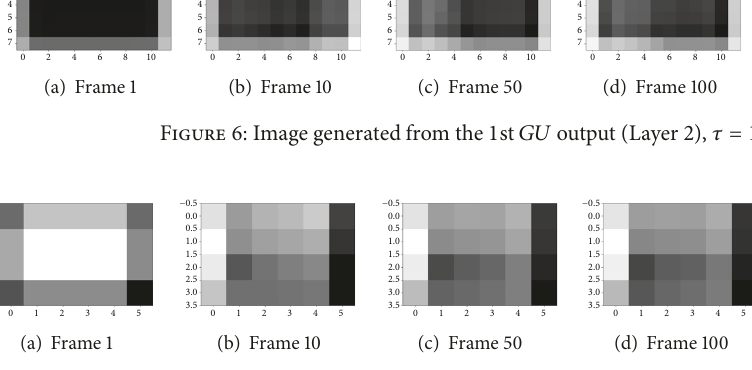
Figure 7: Image generated from the 1 st 𝐺𝑈 output (Layer 3), 𝜏 = 2.0